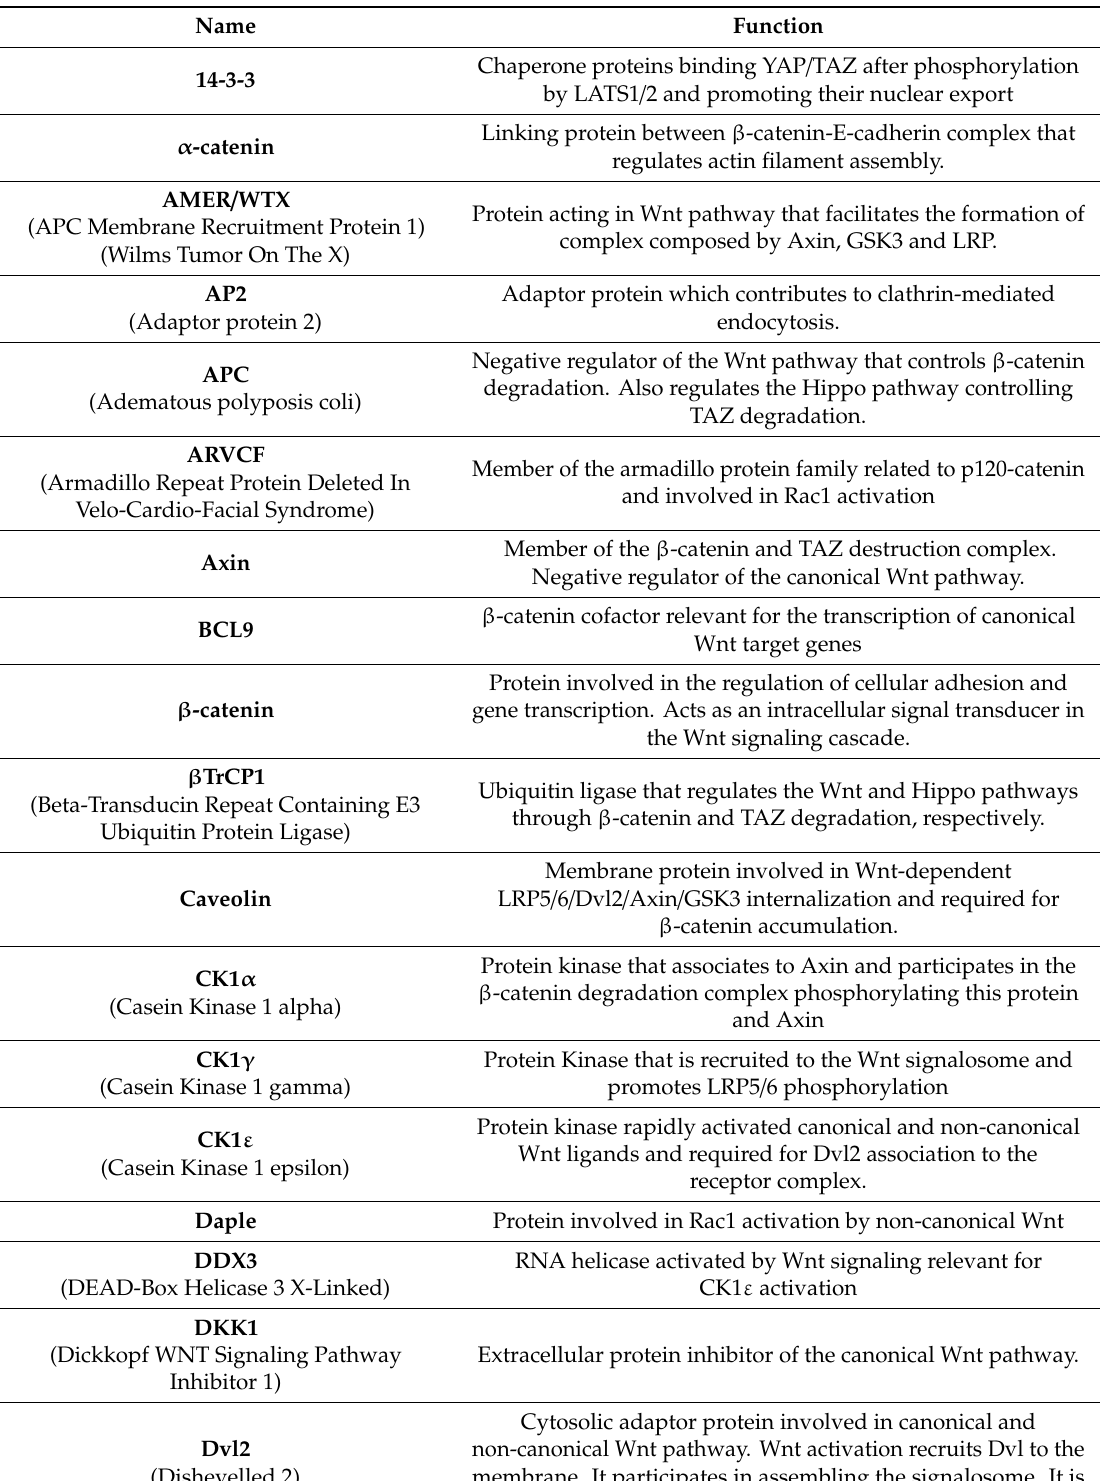
Table 1. Proteins involved in Wnt or Hippo